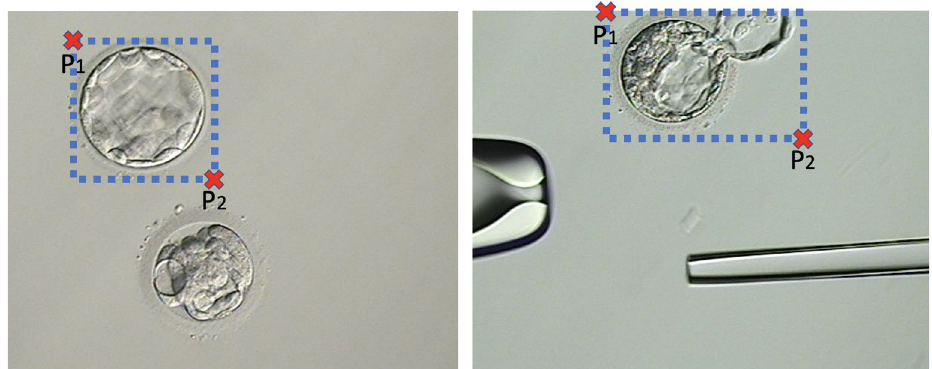
Figure 5. Examples of two blastocyst micrographs and the bounding pox defined by P 1 and P 2